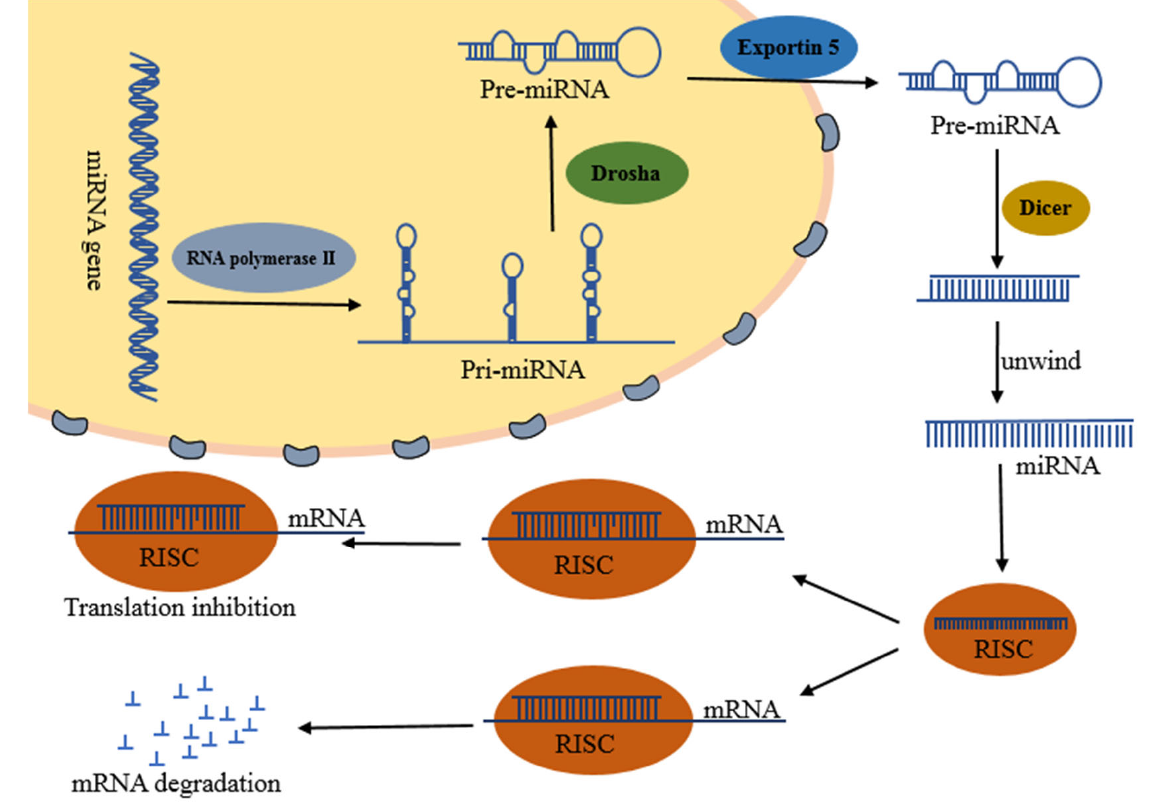
Figure 2. miRNA formation and mechanism of action.